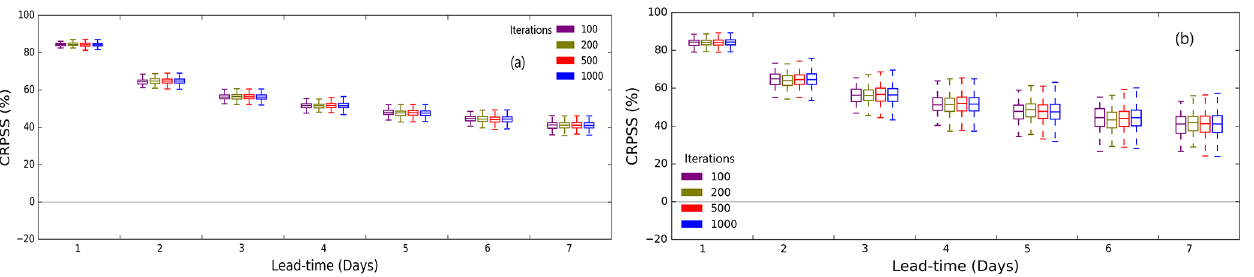
Figure 10. Bootstrapped forecast skill for the Acheron River at the Taggerty site for different number of iterations and block sizes – (a) weekly and (b)